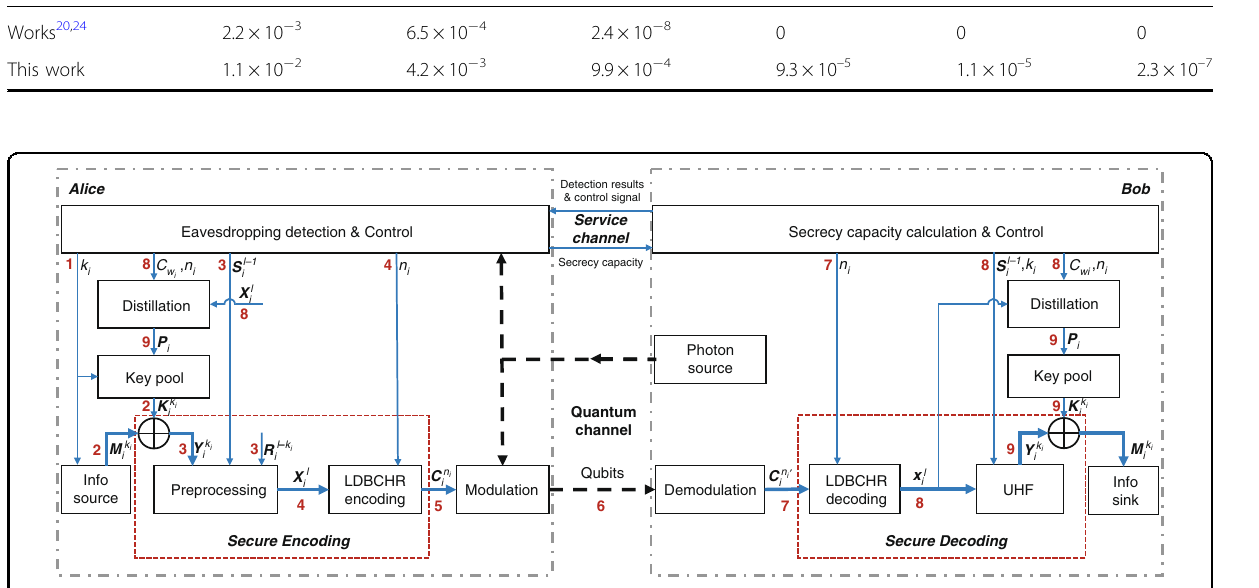
Protocol structure Figure 4 details how Alice sends the i -th frame of message to Bob over the quantum channel with the aid of the clas- sical service channel in our variant of QMF QSDC protocol.